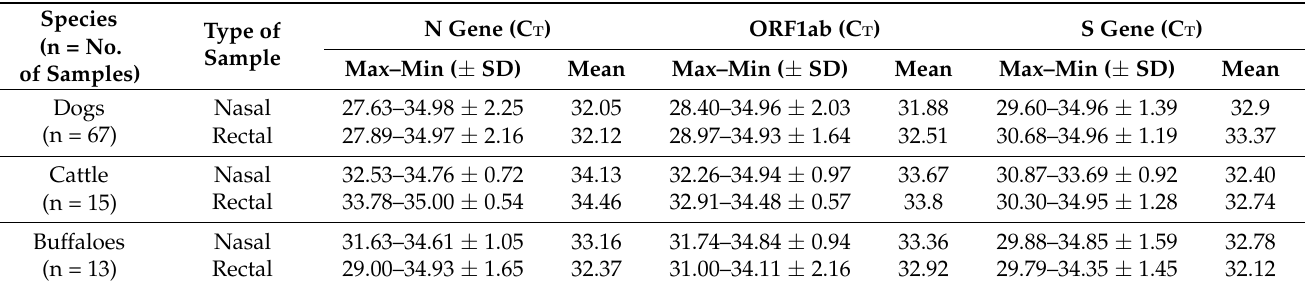
Table 3. Maximum and minimum Ct values obtained in the positive samples of different species during the qPCR of